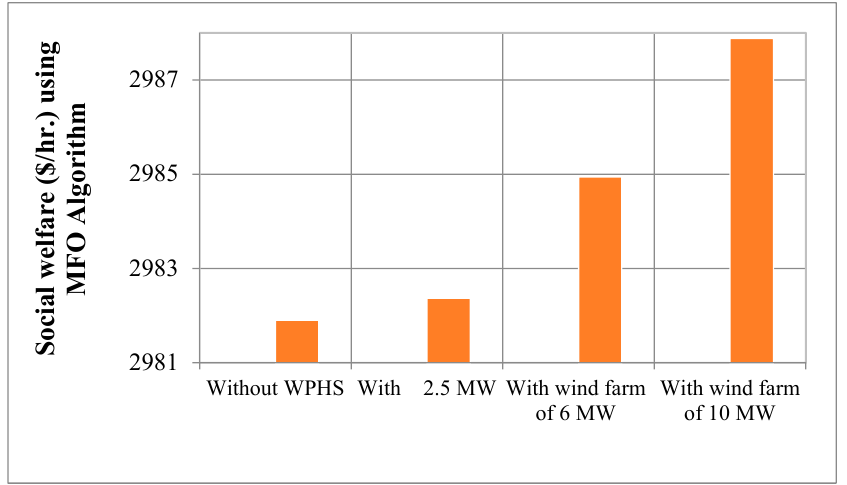
Figure 14. Comparison of social welfare using MFO algorithm.